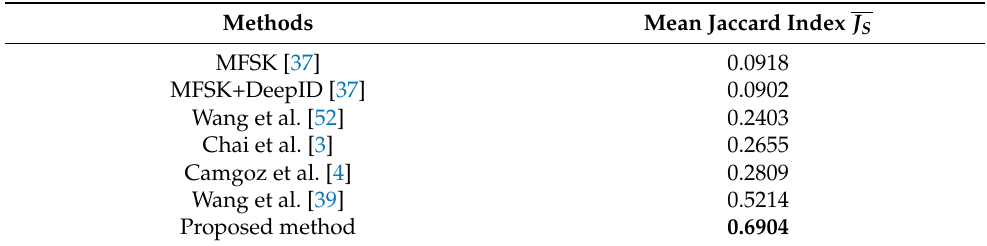
Table 6. Comparison of the proposed method and other methods on the validation set of ChaLearn LAP ConGD Dataset.